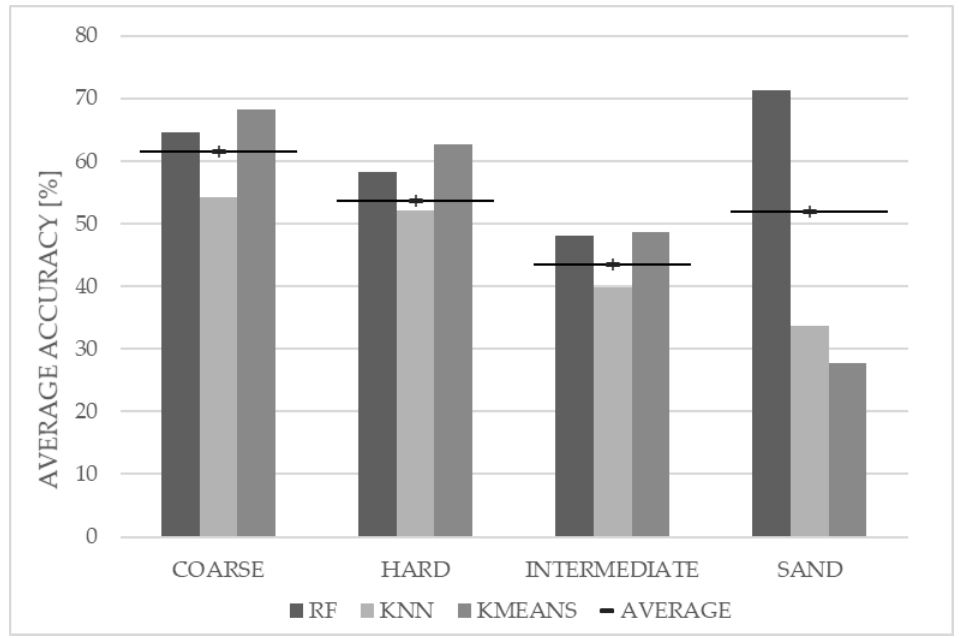
Figure 10. Per class agreement (mean value between user’s and producer’s accuracy) for each habitat class and the three classification models, comparing the 2015 Day 1 and 2015 Day 2 classifications.